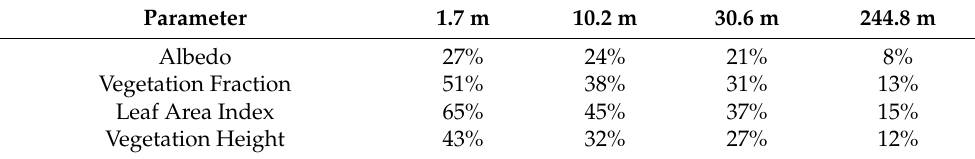
Table 6. Variation coefficient for selected FEST-EWB model inputs across the selected scales.